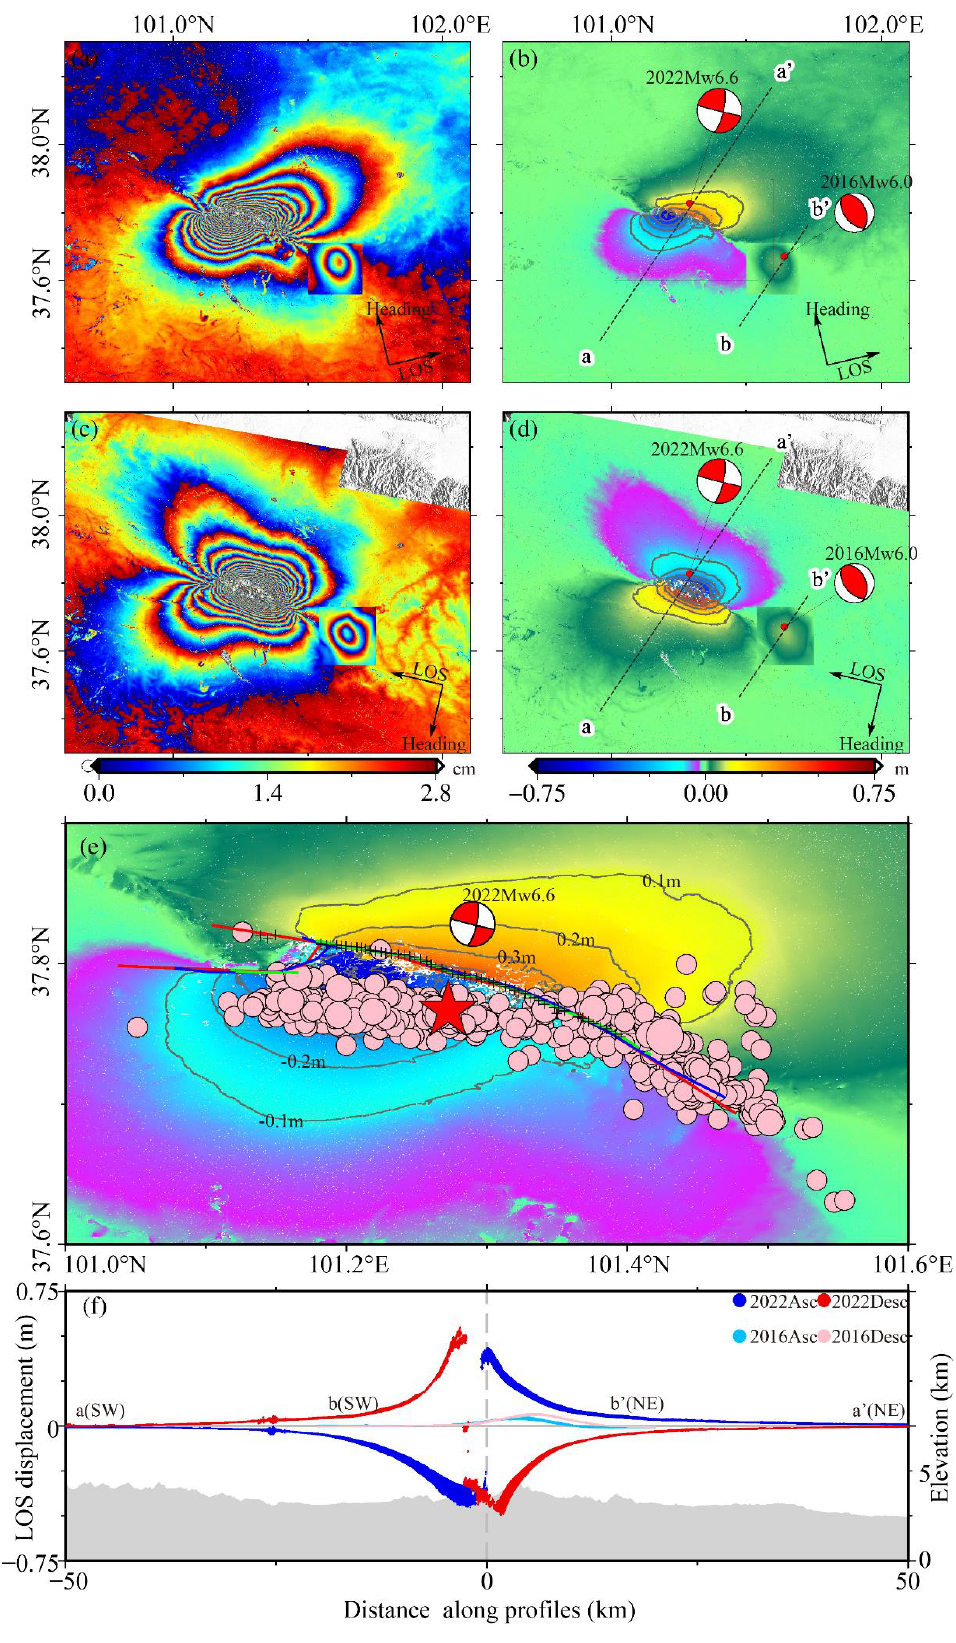
Figure 4. The collage of InSAR coseismic displacement field of the 2016 and 2022 Menyuan earth- quakes. ( a , c ) the wrapped interferograms on ascending and descending tracks. ( b , d ) the